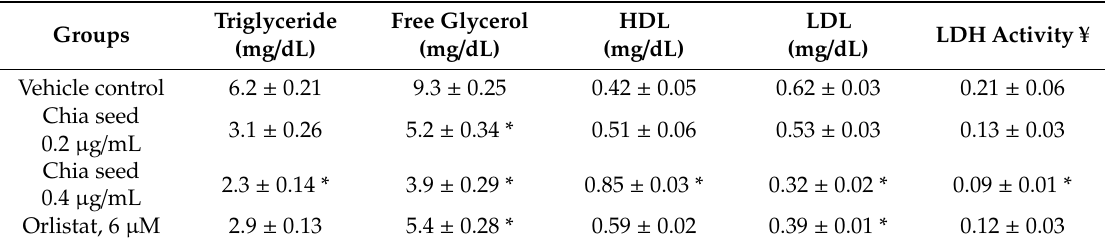
Table 3. E ff ect of chia seed fatty acid extract on triglyceride, free glycerol, high density lipoprotein (HDL), low density lipoprotein (LDL) levels and lactate dehydrogenase (LDH) activity in matured adipocytes after 14